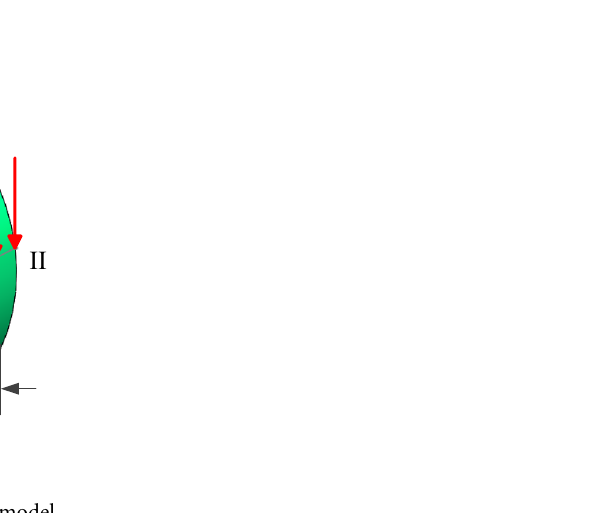
Figure 17. Cylinder-torus plate structure